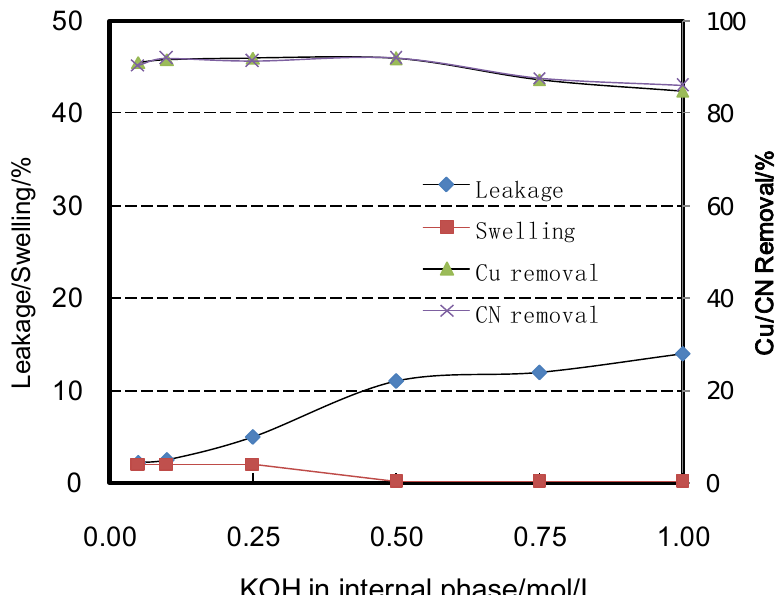
Figure 4. Effect of KOH on ELM stability and copper and cyanide removal. (For ELMs formation, membrane phase: 6% v / v LIX 7950, 2% v / v 1-dodecanol, 5% v / v Span 80, 1% v / v liquid paraffin, balanced with kerosene; Volume ratio of membrane to internal phases: 1:1; Mixing for emulsification: 15 min at 4500 RPM. The external aqueous